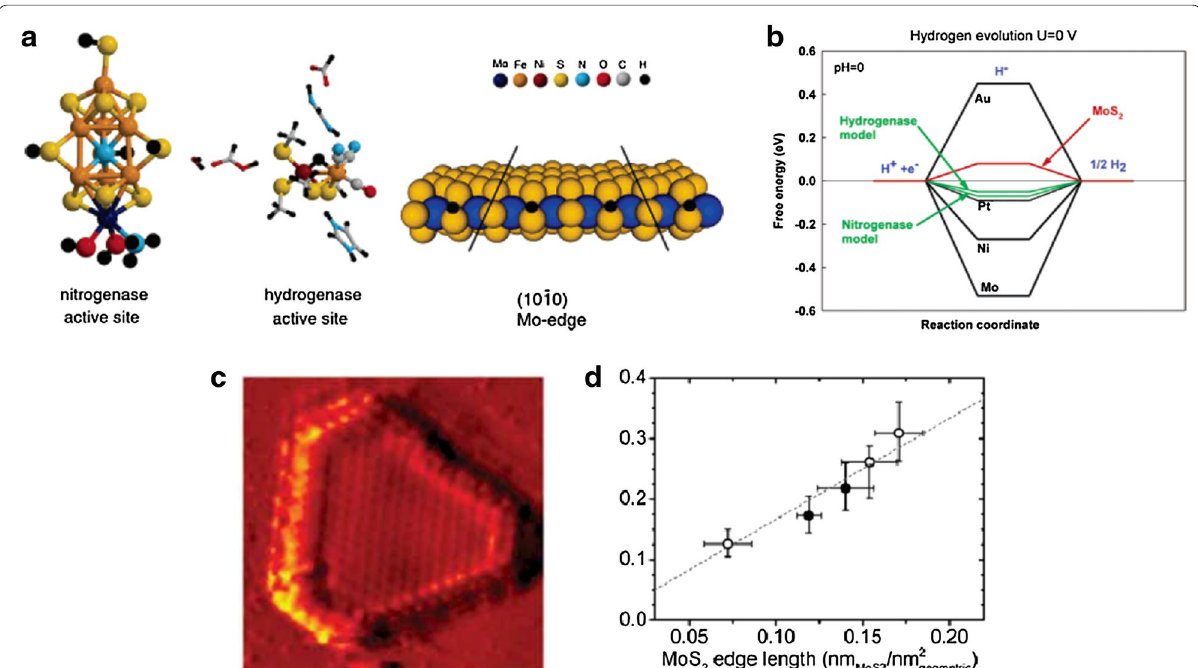
Fig. 2 a Active sites of the nitrogenase and hydrogenase, and depiction of the Mo-edge on MoS 2 slab. b Free energy diagram for hydrogen adsorp- tion. c STM image of MoS 2 nanoparticles on a Au(111) surface. d The exchange current density versus the MoS 2 edge length (Figures reprinted with permission from Refs. [20,